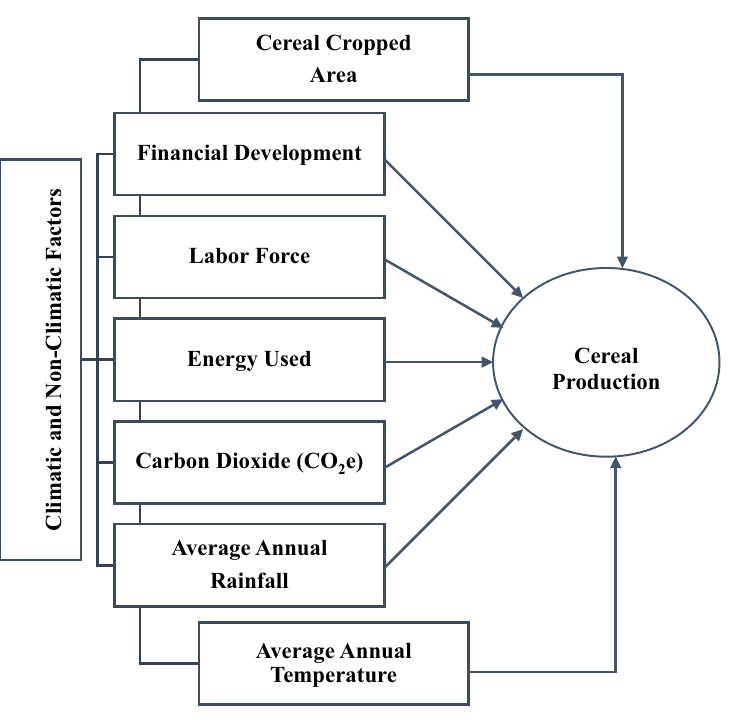
Figure 3. Dynamic interactions between the study